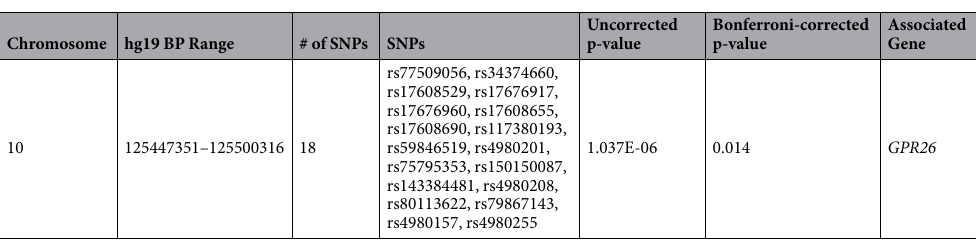
Table 2. SNPs showing significant association with the composite brain/skull